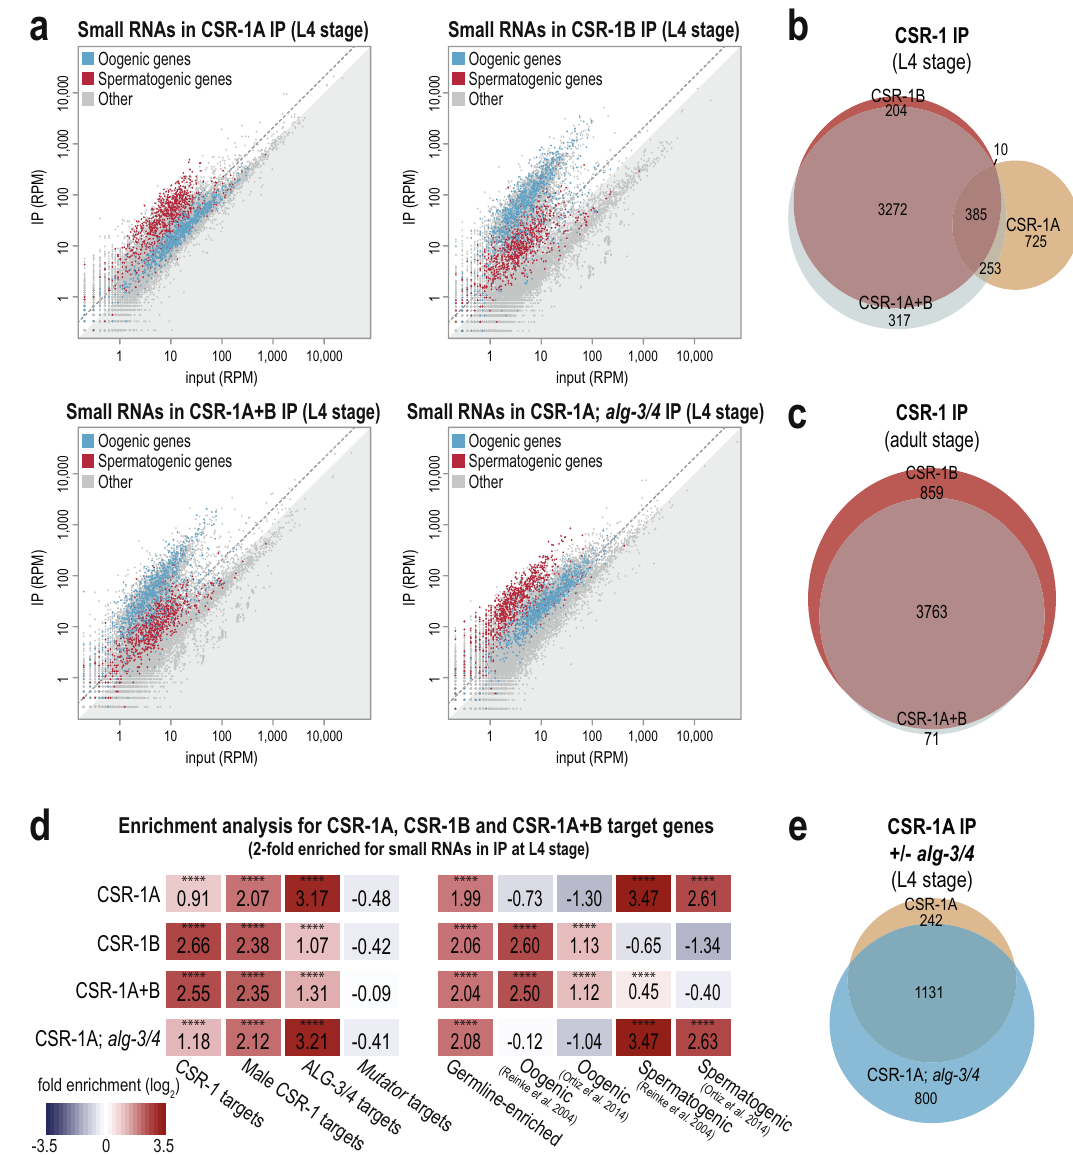
Fig. 4 CSR-1A and CSR-1B target distinct groups of genes. a Normalized reads for oogenesis and spermatogenesis genes at L4 stage from HA::CSR-1A IP, FLAG::CSR-1B IP, FLAG::CSR-1A + B IP, and HA::CSR-1A; alg-3/4 IP compared to input. Oogenic and spermatogenic genes (de fi ned by Reinke et al., 2004) are indicated in blue and red, respectively. Gray dotted line indicates twofold enrichment in IP relative to input. b Venn diagram indicates overlap of CSR-1A, CSR-1B, and CSR-1A + B target genes at L4 stage. Target genes are de fi ned are at least twofold enriched in the IP, with at least 10 RPM in IP samples and a DESeq2 adjusted p value ≤ 0.05. c Venn diagram indicates overlap of CSR-1B and CSR-1A + B gene lists at adult stage. d Enrichment analysis (log 2 (fold enrichment)) examining the overlap of CSR-1A, CSR-1B, and CSR-1A + B target genes with known targets of the CSR-1, male CSR-1, ALG-3/4, and mutator small RNA pathways and oogenesis and spermatogenesis-enriched genes. See Materials and Methods for gene list information. Two-tailed p values for enrichment was calculated using the Fisher ’ s exact test function in R. n.s. denotes not signi fi cant and indicates a p value >0.05 and **** indicates a p value ≤ 0.0001. See Supplementary Data 7 for more details regarding statistical analysis. e Venn diagram indicates overlap of CSR-1A target genes in the presence or absence of alg-4 ; alg-3